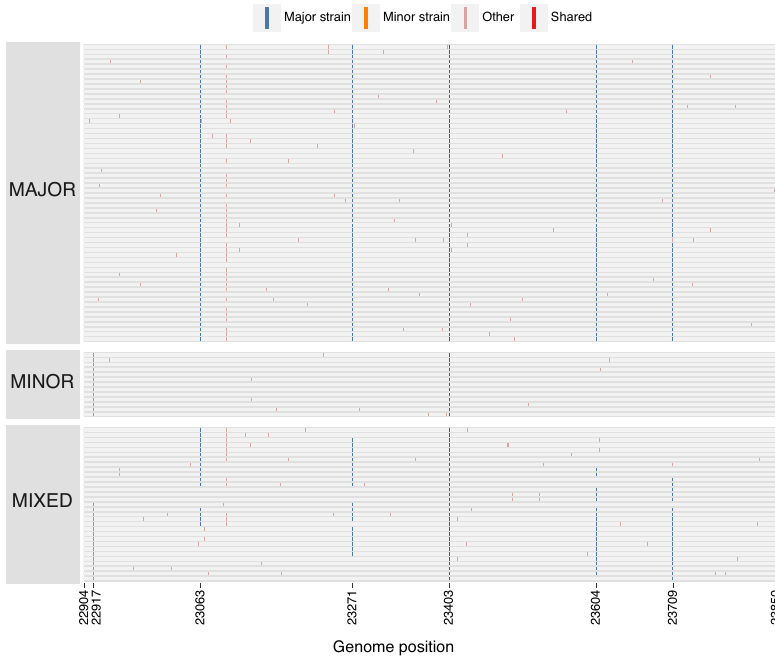
Fig. 3 Major, minor, and mixed haplotypes in the 947 nucleotide S (spike) gene cloned sequences. Each row represents a sequenced clone ( n = 104). Colored markings denote mutations from the reference genome. Major strain mutations are those found in the Alpha variant. Minor strain mutations are those found in Epsilon variant. Other mutations are found at intermediate or low frequencies. Shared mutations are those shared by B.1 viruses.